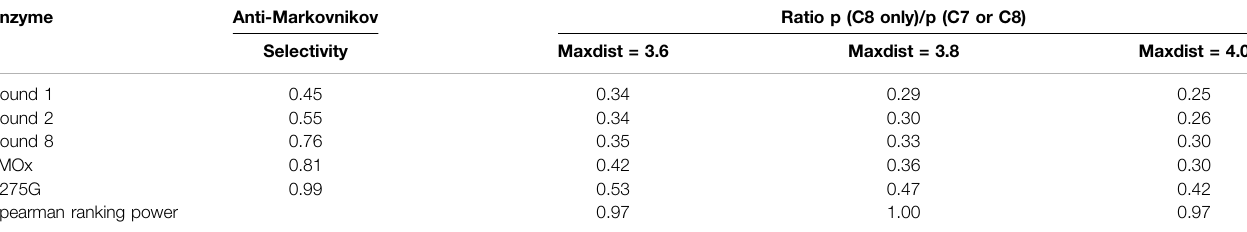
TABLE 4 | Inverse martensite selectivity of the system and the ratio of p (C8 only)/p (C7 or C8) in the simulated trajectories of aMD at different distance thresholds. Enzyme Anti-Markovnikov Ratio p (C8 only)/p (C7 or C8) Selectivity Maxdist = 3.6 Maxdist = 4.0 Round 1